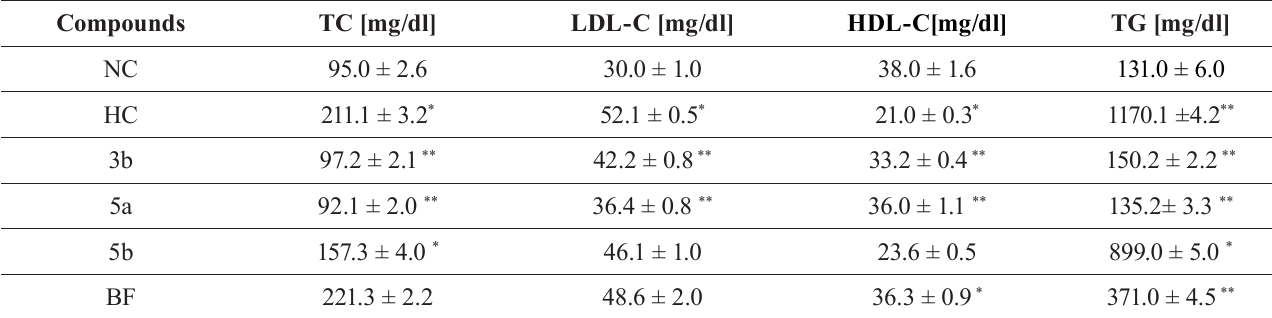
TABLE I - R esults of plasma lipid levels for compounds 3b , 5a , 5b and BF in Triton WR 1339 induced hyperlipidemic rats after 18 h